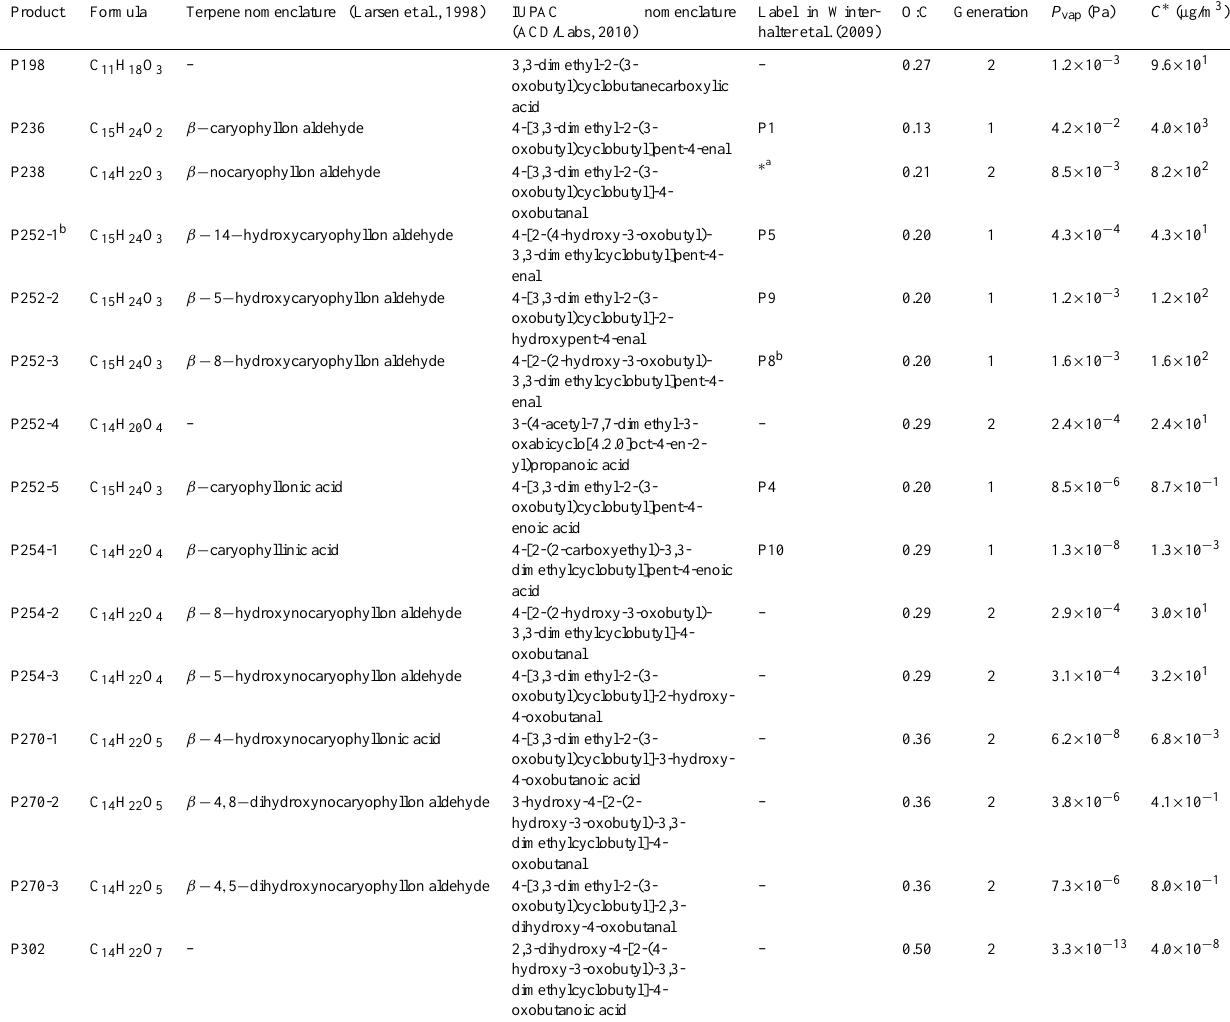
Table 2. Product labels, molecular formulas, oxygen-to-carbon elemental ratios (O:C), product reaction generation, estimated saturation vapor pressures P vap , and estimated saturation vapor concentrations C ∗ of molecules produced by the dark ozonolysis of β -caryophyllene and as detected in the present study. Saturation vapor pressures were estimated using the SPARC on-line calculator (http://sparc.chem.uga. edu/sparc/) (Hilal et al., 2003). Table entries also include products as labelled by other conventions, including terpene nomenclature (Larsen et al., 1998), the IUPAC system (ACD/Labs, 2010), and that of Winterhalter et al. (2009). Terpene nomenclature (Larsen et al.,